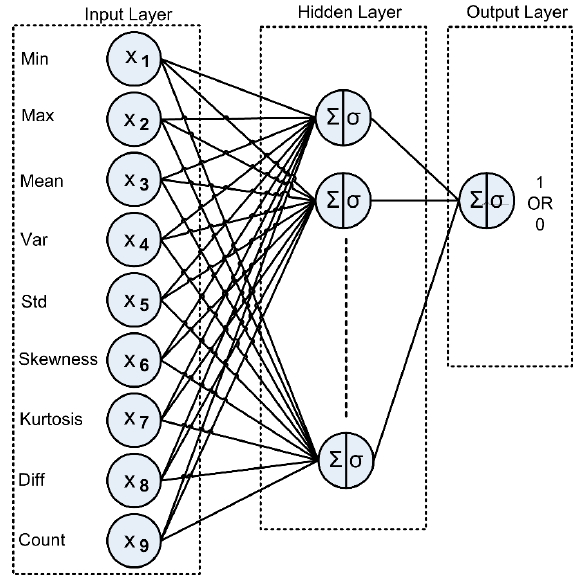
Figure 6. Multilayer perceptron model for RFID classification.